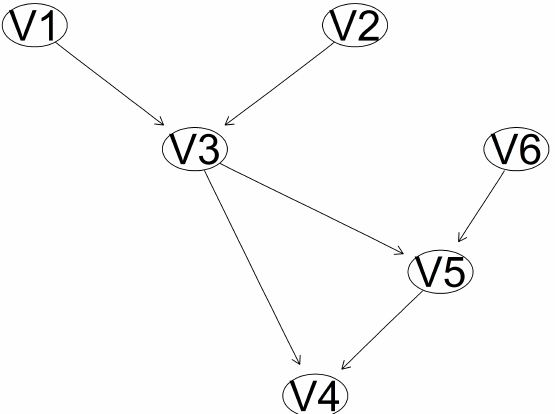
Figure 1. An example of a DAG. Nodes V1 and V2 are the parents of V3, whose children are nodes V4 and V5. V2 is the spouse of V1 (and vice versa, V1 is the spouse of